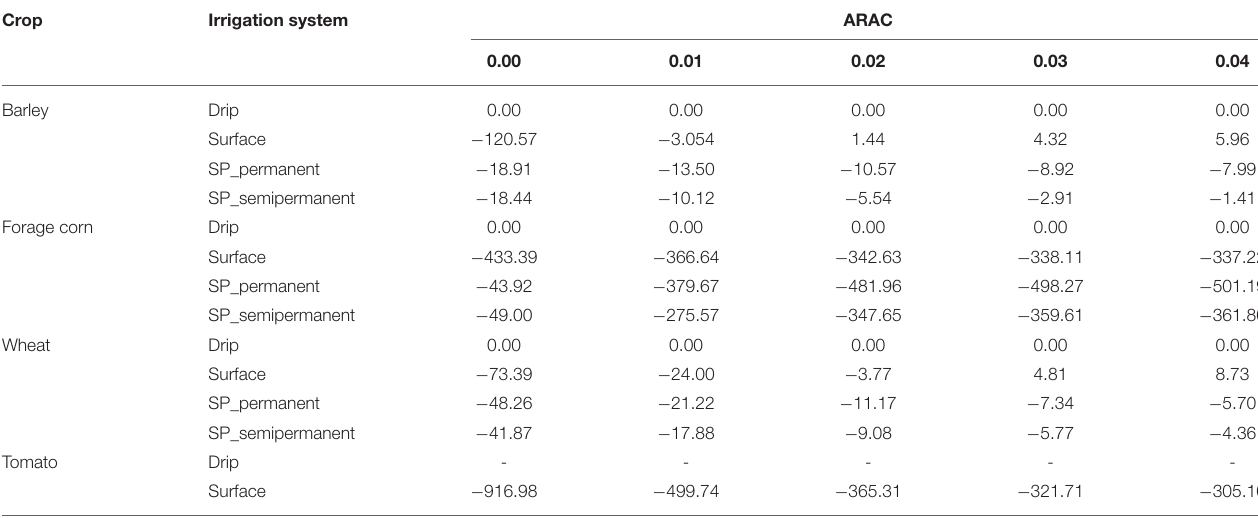
TABLE 8 | Risk premiums (10,000 Rials/ha) for various absolute risk-aversion coefficients. Crop Irrigation